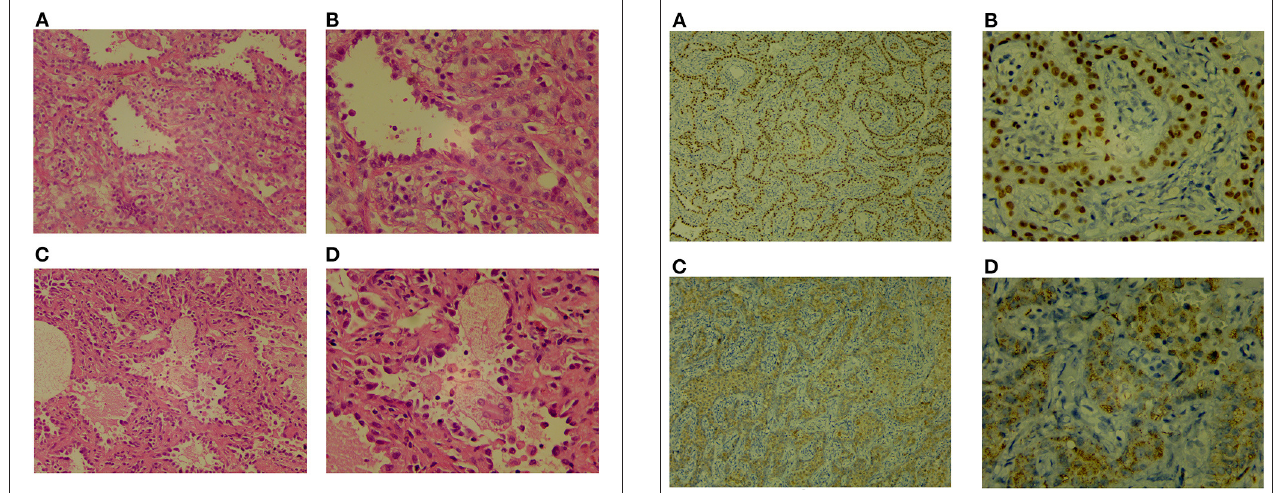
FIGURE 3 | Immunohistochemistry [TTF-1 ( + ), Napsin A ( + )]. (A) TTF-1 × 100. (B) TTF-1 × 400. (A,B) Positive staining of TTF-1 in the nuclei of